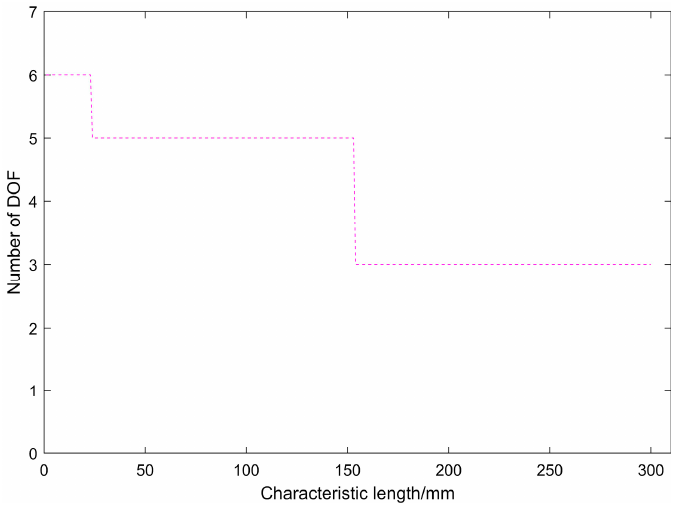
Figure 6. The relationship between the number of DOF and the value of the characteristic